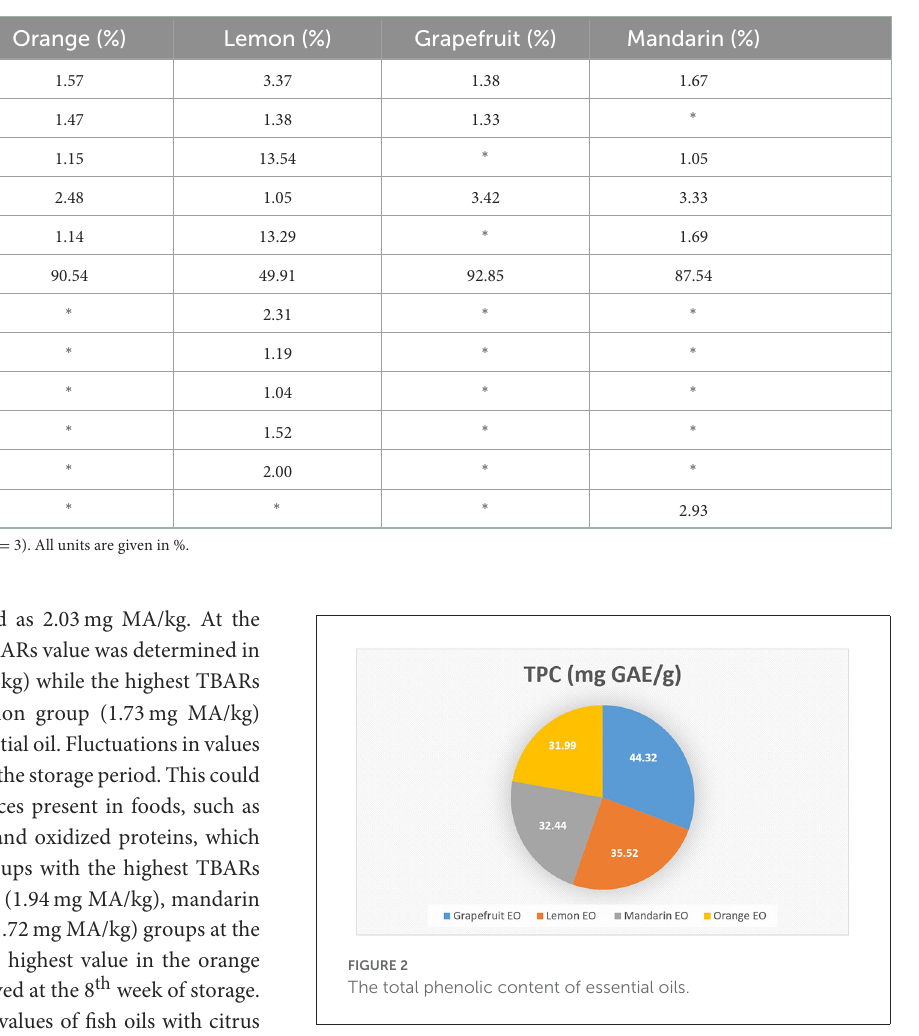
TABLE 3 Major volatile component of citrus peels essential oils identified by GC/MS.